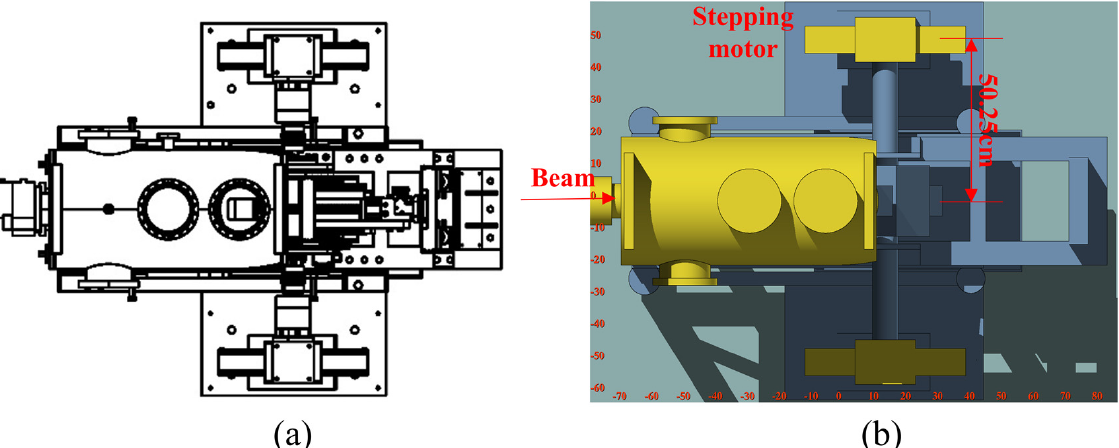
Figure 15. ( a ) Two-dimensional diagram of the motor region, ( b ) motor region geometry in Flair. Distances are given in cm.